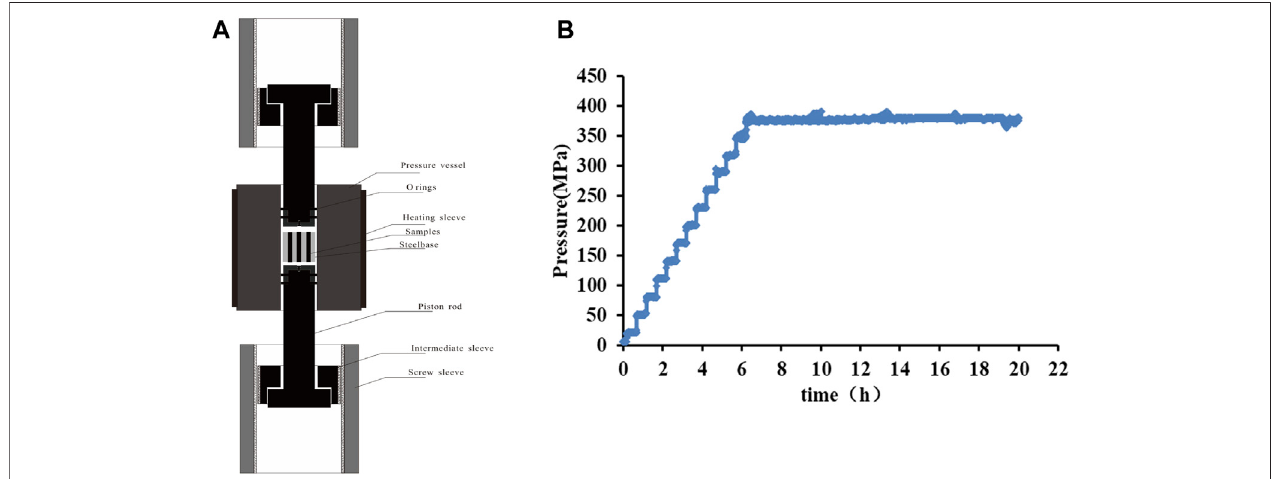
FIGURE 1 | (A) Schematic illustration of the Wood ’ s metal injection setup and (B) injection pressure time plot showing a step-wise pressure increase up to 380 MPa during Wood ’ s metal injection.